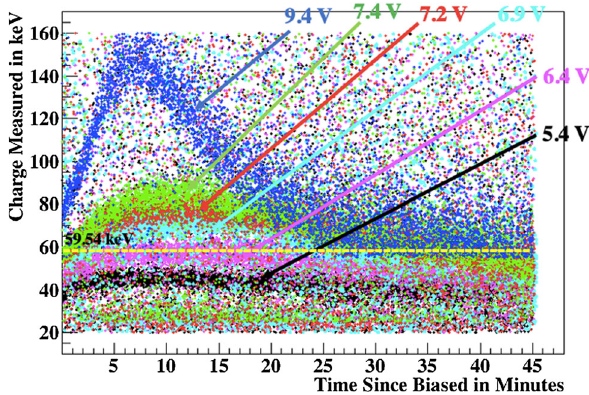
Fig. 5 Shown is the time-dependent charge response from Q4 at posi- tive biases for Run 74. The baseline of 59.54 keV gamma ray from Q4 initially rose linearly for a few minutes, then quickly transitioned to an ∼ exponential fall off over 10s of